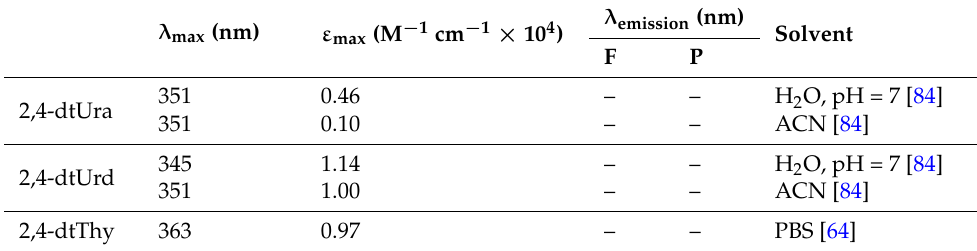
Table 8. Steady-state absorption and emission properties of 2,4-dithiopyrimidine derivatives at room temperature. F: Fluorescence; P: